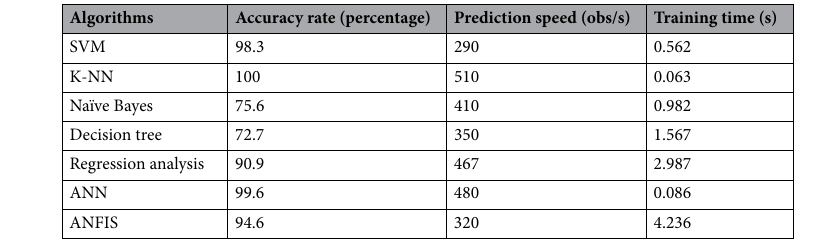
Table 10. Performance analysis of various algorithms.